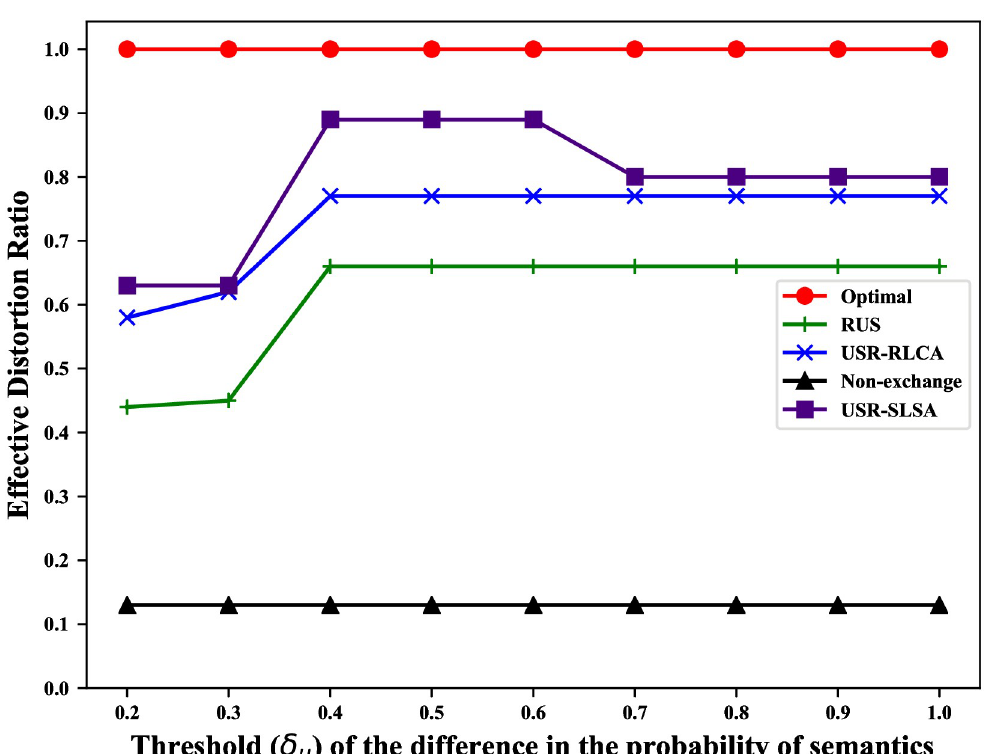
Fig 8. Impact of δ u on the privacy-preserving